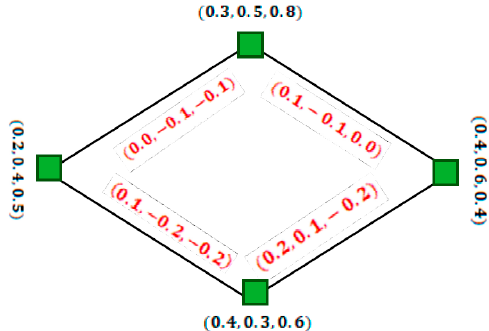
Figure 16. Single-valued neutrosophic graph.